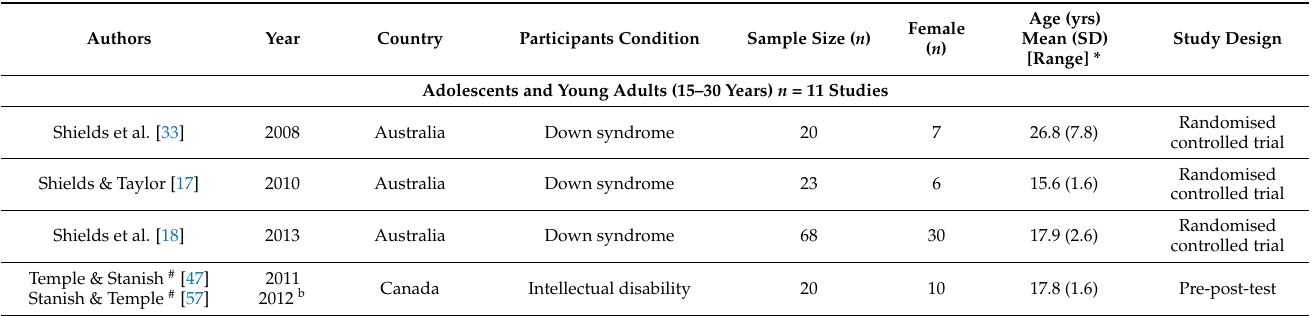
Table 1. Characteristics of included studies grouped according to whether participants were ado- lescents and young adults (15 – 30 years) or adults (30+ years).